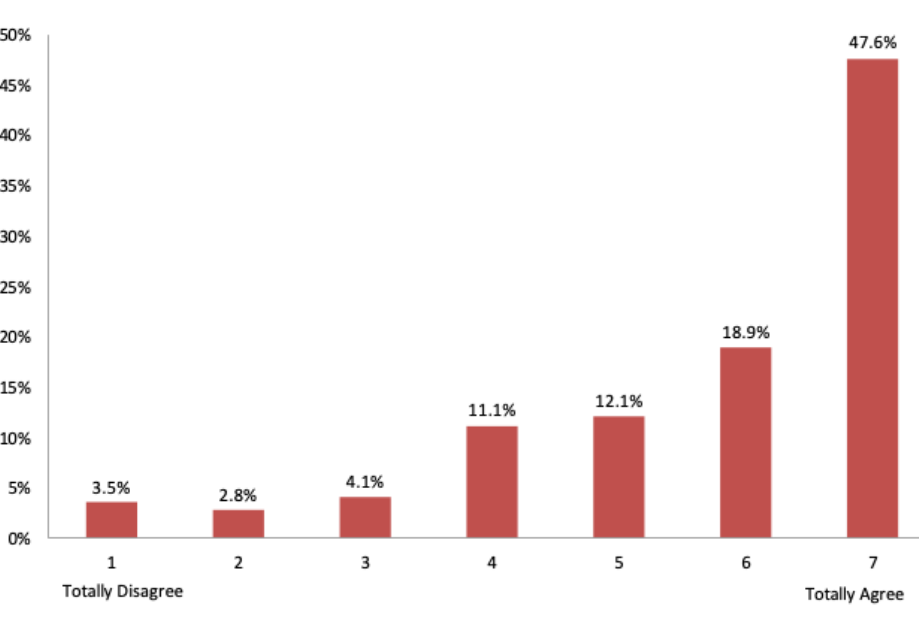
Figure 5: ’Web store should be obliged to inform customers if they charge different prices to different visitors, for the same product’